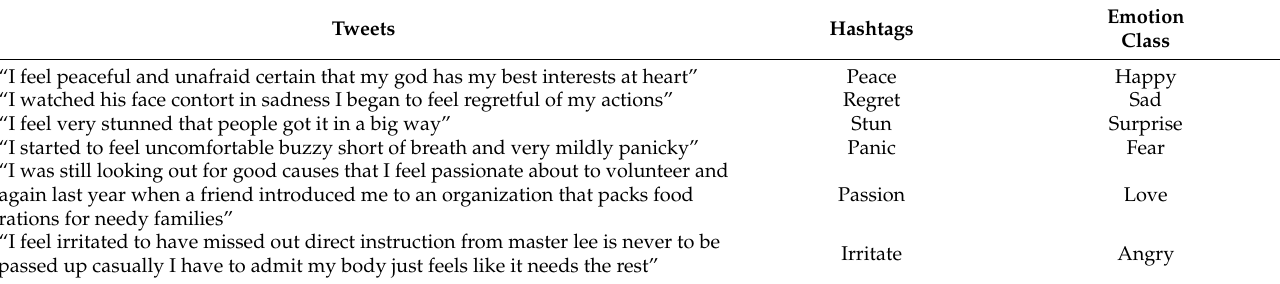
Table 6. Emotion Analysis Dataset